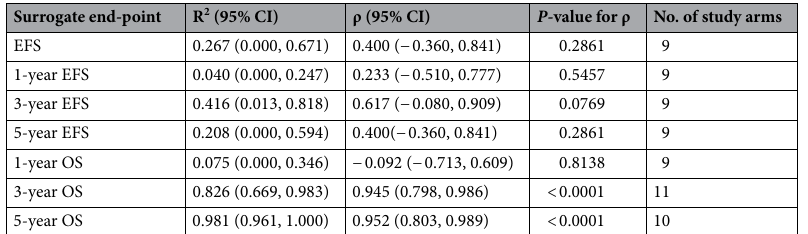
Table 5. Sensitivity analysis to evaluate surrogacy. Abbreviations: CI, confidence interval; EFS, event-free survival; OS, overall survival.